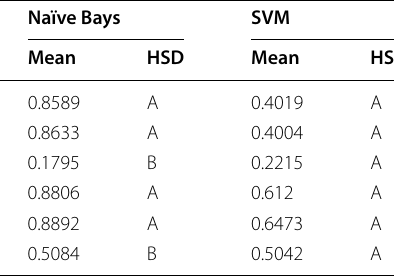
Table 9 Performances of the similarity measures using classification learners averaged across all data sets